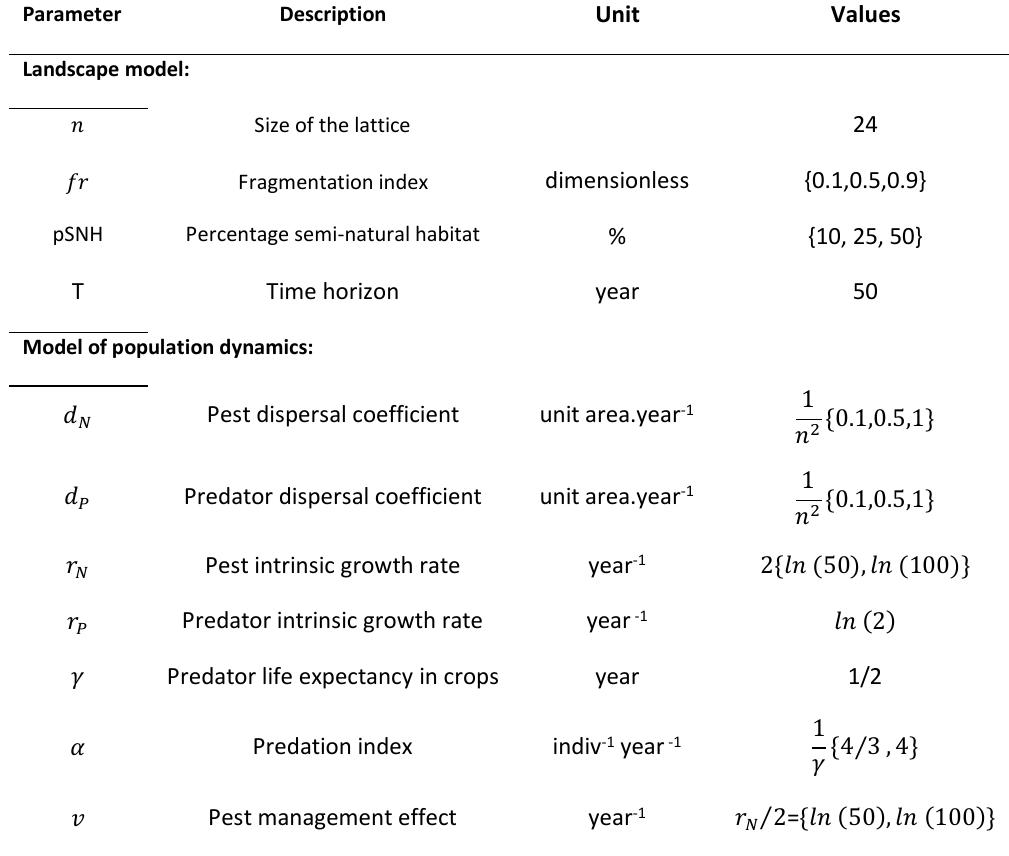
Table 1 - List of model